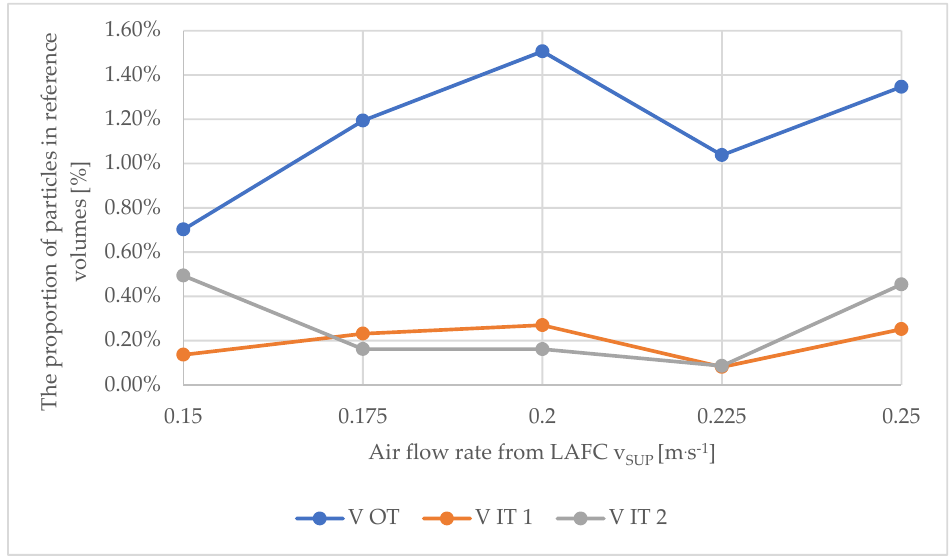
Figure 5. Percentage of particles in reference volumes depending on the airflow rate from LAFC.